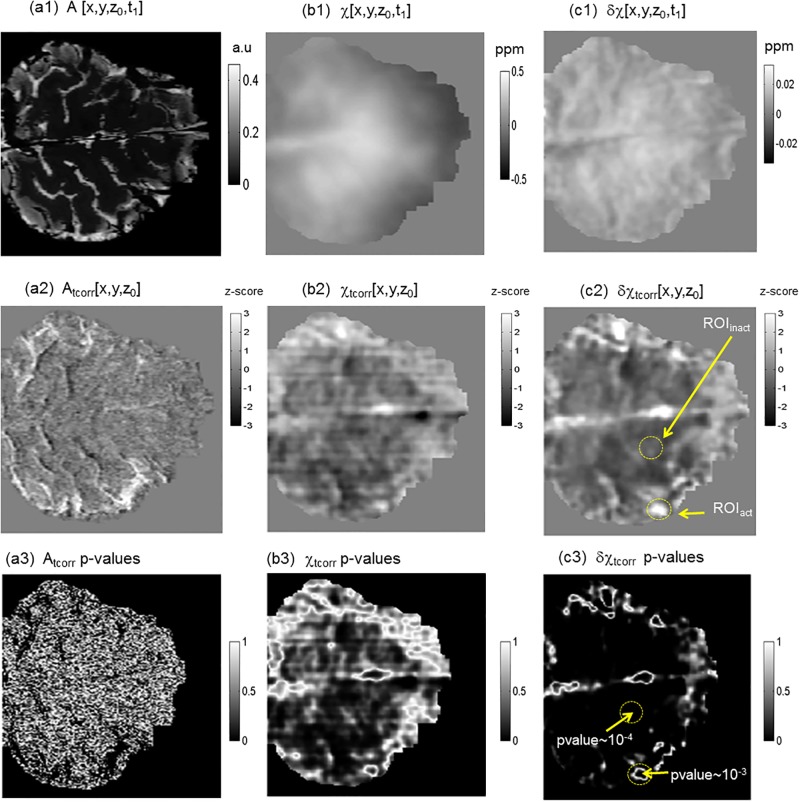
Task-evoked brain functional mappings in different dataspaces: (a1, a2, a3) T2* magnitude image dataspace A[r,t]; (b1,b2,b3) the reconstructed χ[r,t] source dataspace (including static background); (c1,c2,c3) the reconstructed δχ[r,t] source dataspace (pure BOLD χ responses).In (c2), the ROIact defines a task-evoked active region of interest, and the ROIinact defines a task-irrelevant region of interest.